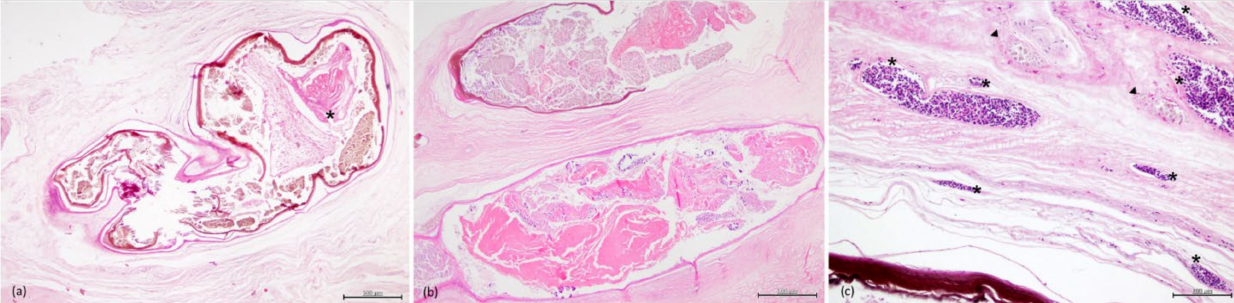
Figure 6. Histology, HE stain. ( a , b ) Encysted degenerated plerocerci, on occasions with fragments of the hooked tentacles (*), and finely stippled to coarse, strongly eosinophilic, golden-brown and basophilic debris (mineralization), enclosed by a fibrous capsule (scale bars = 500 µ m). ( c ) Stomach submucosa, proliferation of small-caliber blood vessels (*) and MA surrounding (arrowheads) the degenerated plerocerci (scale bar = 100 µ m).